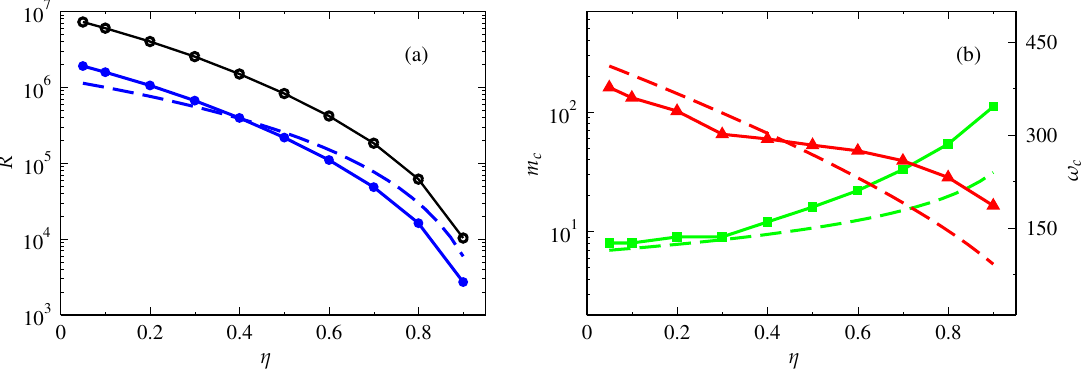
Figure 3. Critical parameter values for the onset of convection and values of the Rayleigh number used in this work as a function of the shell thickness aspect ratio η in the case P = 0.75, and τ = 2 ( a ) The critical Rayleigh number R c for the linear onset of convection is plotted in solid blue curve marked by full circles. The values used in the simulations are given by R = 3.8 R c ; they are plotted in solid black curve marked by empty circles. ( b ) The critical wave number m c (left y -axis) and the critical frequency ω c (right y -axis) for the onset of convection are denoted by green squares and red triangles, respectively. Local asymptotic approximations (12) are shown by correspondingly coloured dashed curves in all panels. (Colour